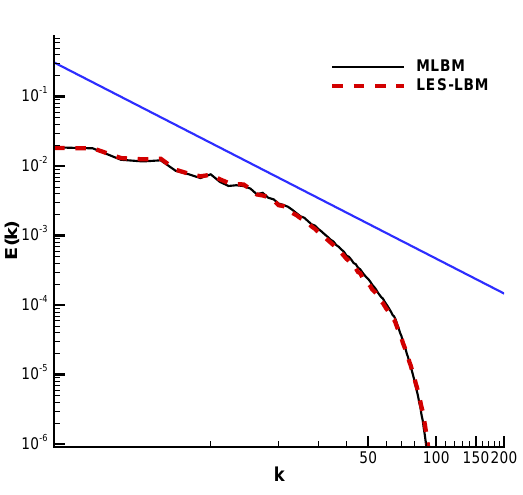
Fig. 10 Comparison of energy spectrum E(k) at t = 3, Re λ = 314 on mesh 256 3 . The straight line represents k − 5 3 .